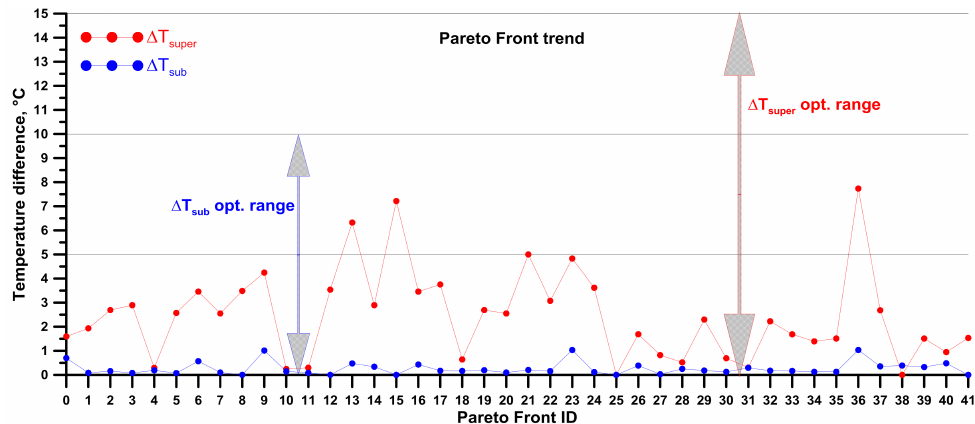
Figure 16. History chart of the superheating and sub-cooling